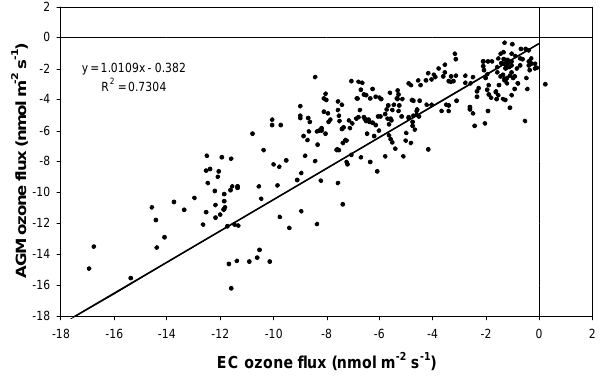
Figure 9: Comparison between O 3 fluxes measured using aerodynamic gradient method and eddy-covariance method. The measured fluxes were corrected for chemical reactions.